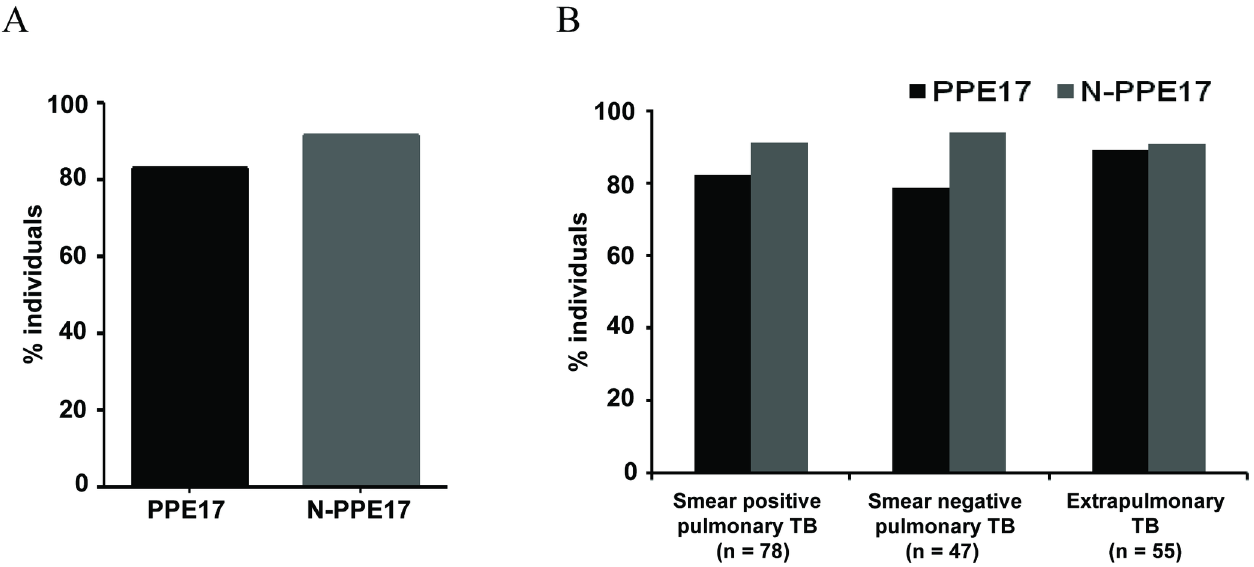
Fig 2. The N-terminal fragment of PPE17 (N-PPE17) is more sensitive to detect TB cases than full-length PPE17 protein. (A) The percentages of high-level responders(patients showingantibody levels greater than or equal to the cut-off values)shown in Fig 1A were calculated using a cut-off value (mean OD 492 of healthy control sera plus 3 SD) for PPE17 and N-PPE17. (B) The percentageof highlevel responderswas comparedfor pulmonary (smear-positive and smear-negative) and extrapulmonary TB cases.